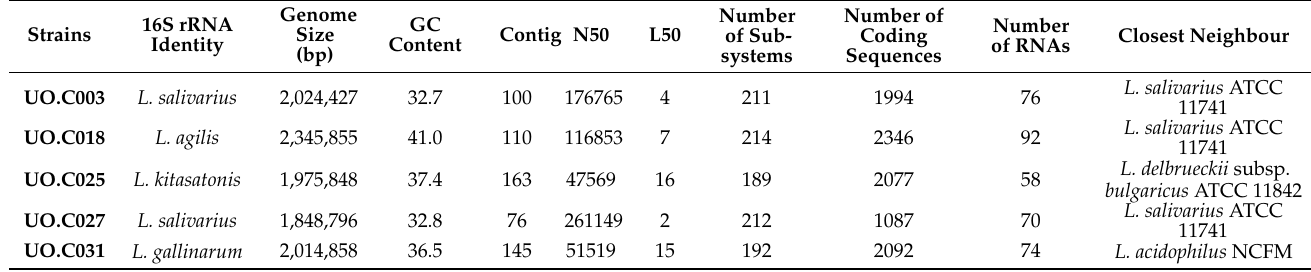
Table 3. Whole genome draft sequence overview as annotated by Rapid Annotation using Subsystem Technology (RAST) server. Strains 16S rRNA Identity